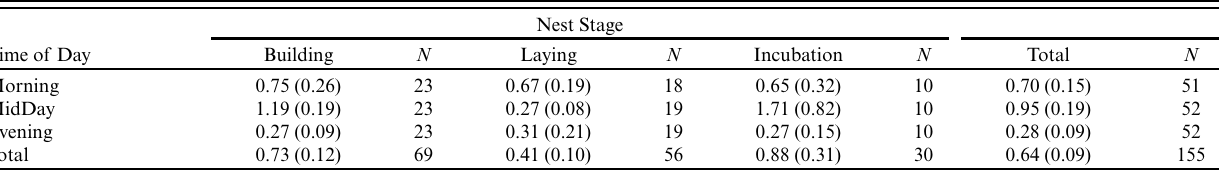
Table 2. Male Black-capped Vireo vocalization rates (songs/minute) near nests in central Texas, 2013–2014. N is the number of 30-min recordings collected for each nest stage and time of day. Each nest we observed was recorded during a single nest stage and typically provided three 30-min recordings, one during each time period. Standard errors are in parentheses Nest Stage Time of